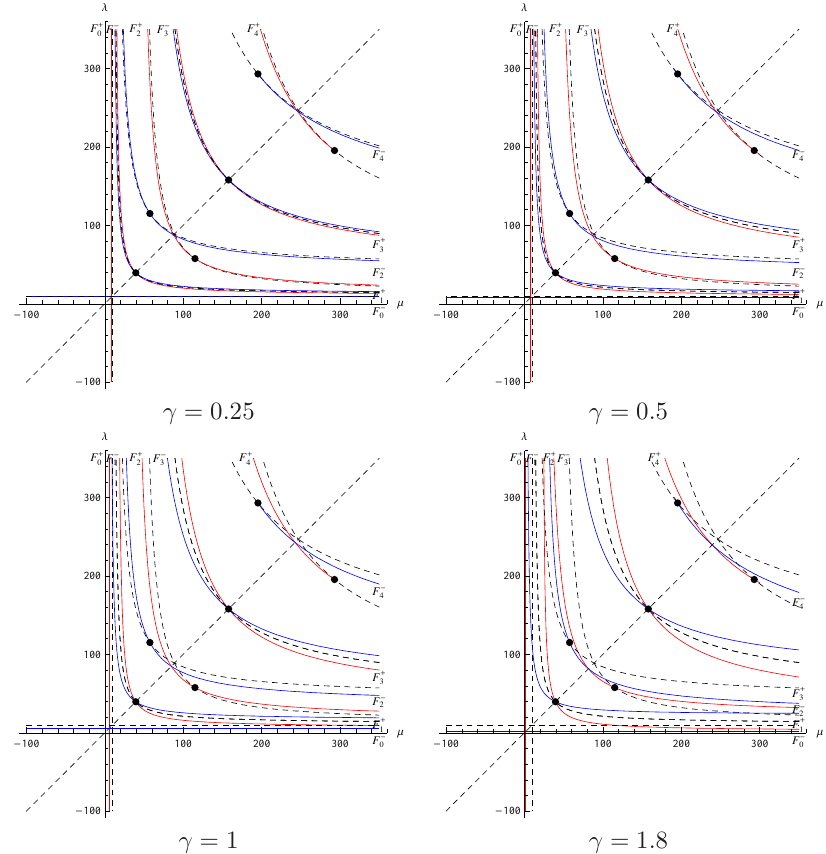
Figure 2. The spectrum for the problem (1.1), (1.4) for different γ